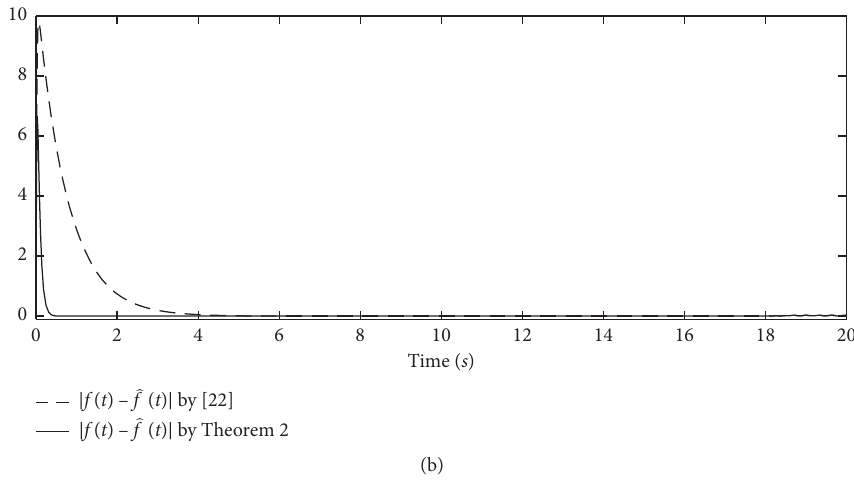
Figure 6: (a) Time evolution of fault and its estimates. (b) Error estimation of fault.